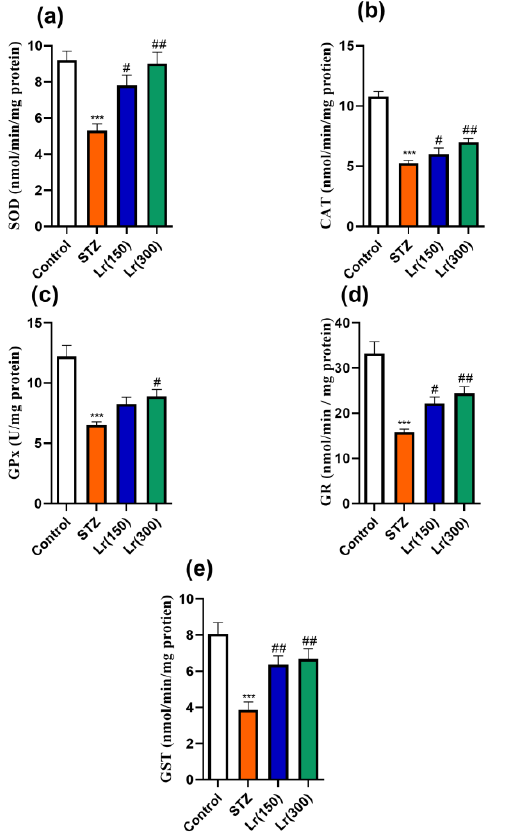
Figure 6. Effect of L. regularis (150 or 300 mg/kg for 4 consecutive weeks) on diabetic-induced changes in renal pro-oxidative enzymatic activities of superoxide dismutase (SOD), catalase (CAT), glutathione peroxidase (GPx), glutathione reductase (GR) and glutathione-S-transferase (GST). Data are expressed as means ± SE ( n = 6) and were analyzed using one-way ANOVA followed by Student Newman–Keuls as post hoc test. * Control vs. STZ group; # STZ vs. L. regularis (150) or L. regularis (300). # p < 0.05, ## p < 0.01, *** p < 0.001.